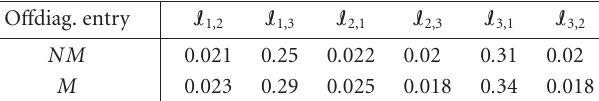
Table 5: Standard deviations of the o ff diagonal entries I ij defined by (22) obtained while separating realistic component maps using JADE, with ( M ) and without masking ( NM ) part of the data. Com- ponents 1, 2, and 3, respectively, stand for CMB, dust, and SZ. O ff diag.